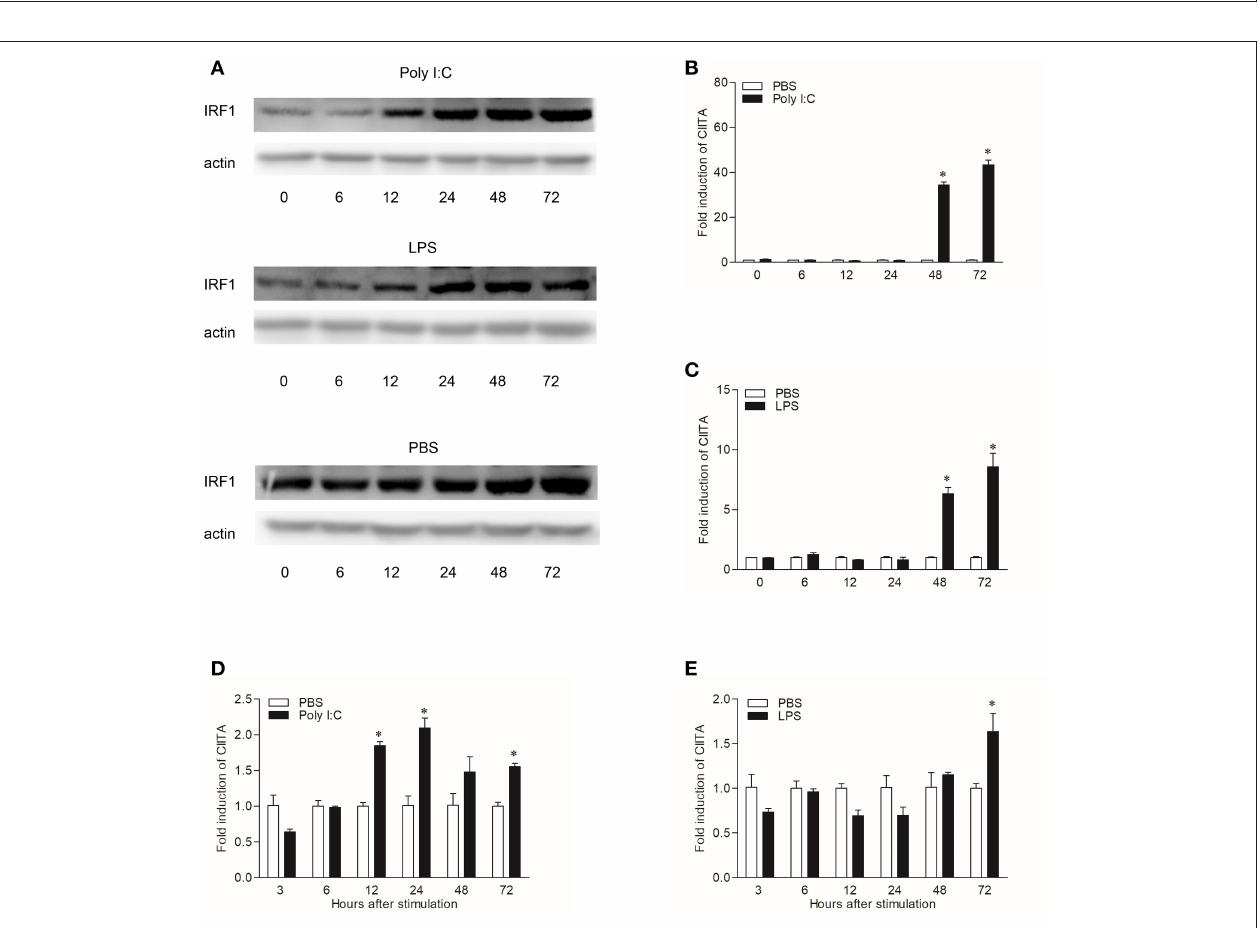
FIGURE 5 | Induction of IRF1 and CIITA by Poly I:C and LPS. (A) Grass carp IRF1 expression in CIK cells stimulated with Poly I:C or LPS. Cell samples were harvested at different time points after stimulation and the gene expression were measured through Western blot. (B,C) Grass carp CIITA expression in CIK cells stimulated with Poly I:C or LPS. Cells were harvested at different time points after stimulation and fold changes of gene expression were measured through qRT-PCR. The expression level was first normalized to that of β -actin and then a stimulated group divided by that of the time-matched controls. (D,E) Grass carp CIITA expression in HKLs stimulated with Poly I:C or LPS. Freshly prepared HKLs were treated with PBS as control or stimulated with Poly I:C or LPS. The mean ± SEM of three fish is shown. Asterisks (*) indicate significant differences from control ( p <